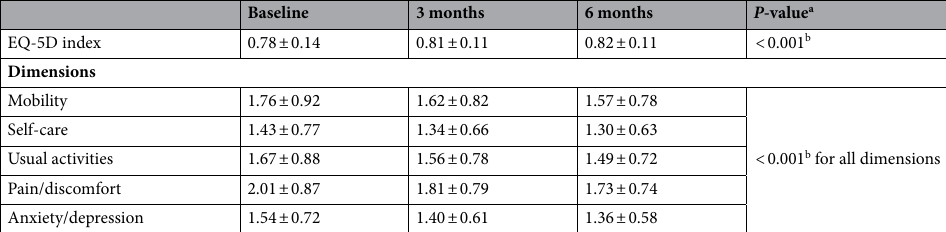
Table 2. Changes in quality of life assessed by EQ-5D after treatment. Data are presented as mean ± SD. a By repeated measures analysis of variance. b Post hoc result by Bonferroni, there is a difference between all times ( P -value < 0.001). EQ-5D, European Quality of Life Instrument 5